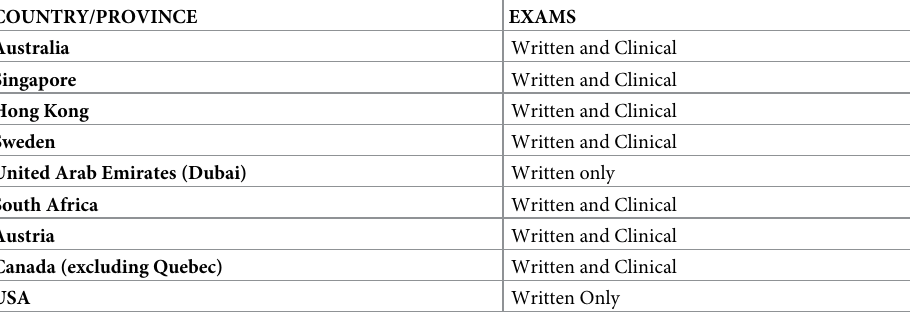
Table 3. Examination requirements for international